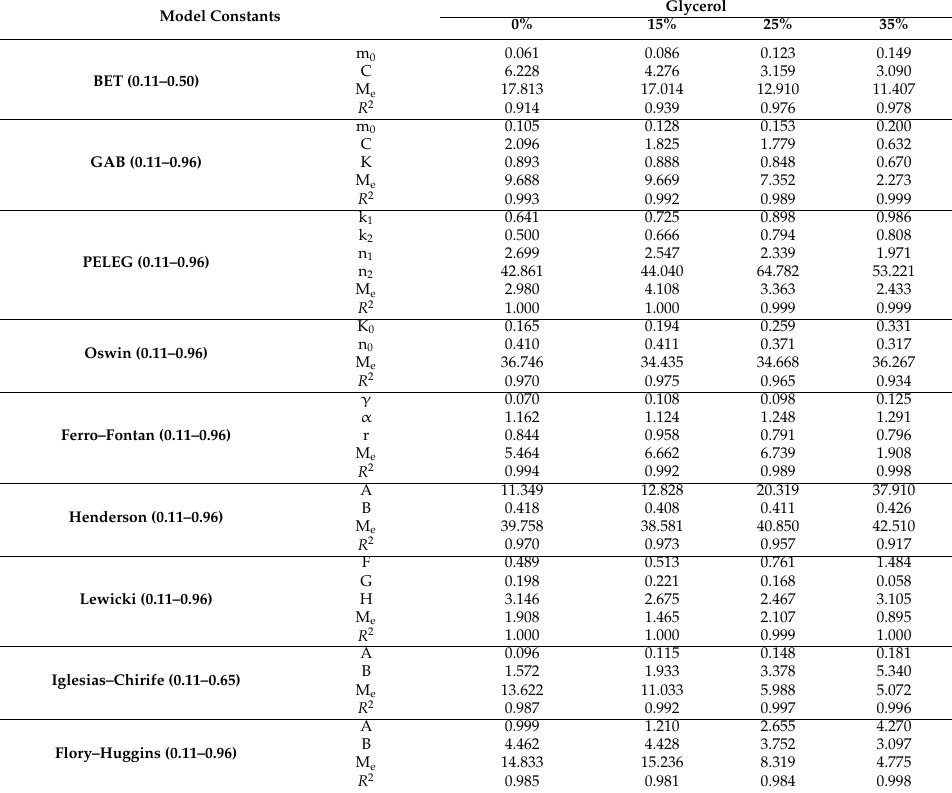
Table 2. Estimated model constants and values of coefficients and mean relative percentage deviation moduli for different pea starch films at 5 ˝